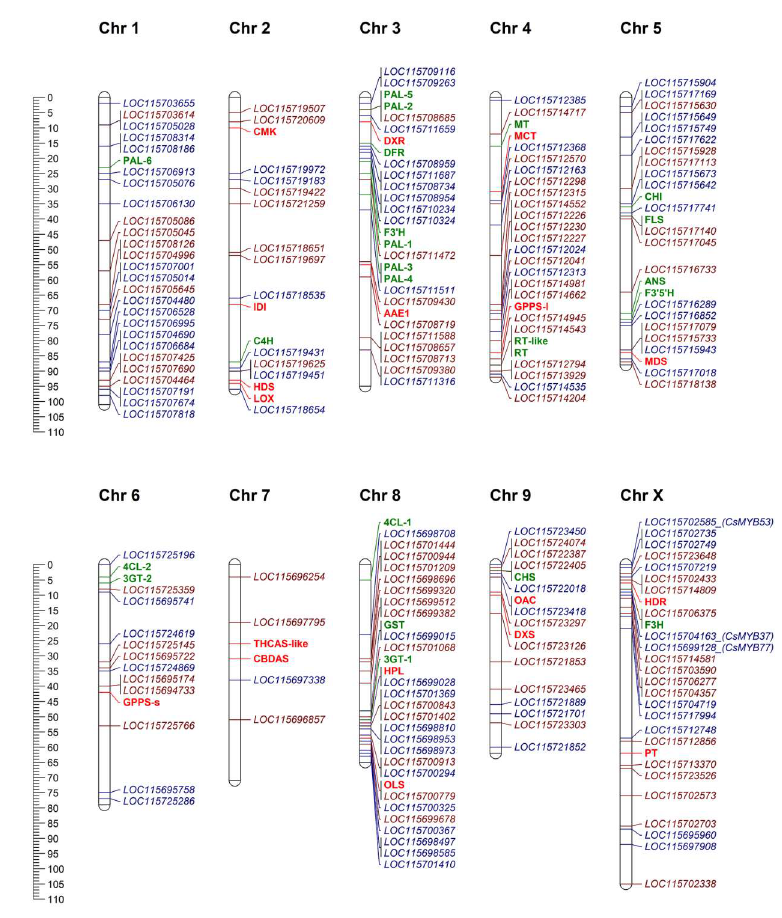
Figure 7. Chromosomal distribution of TFs and genes involved in flavonoid and cannabinoid pathways. Genomic loci corresponding to CsMYB s and CsbHLH s identified in this work are marked in blue and red, respectively. The position of genes encoding for flavonoid (in green) and cannabinoid (in red) enzymes is indicated by their acronym in capital letters on each chromosome. For the cannabinoid pathway, full names of represented genes are: AAE1, acyl activating enzyme 1; CBDAS, cannabidiolic acid synthase; CMK, 4-diphosphocytidyl-2-C-methyl-D-erythritol kinase;